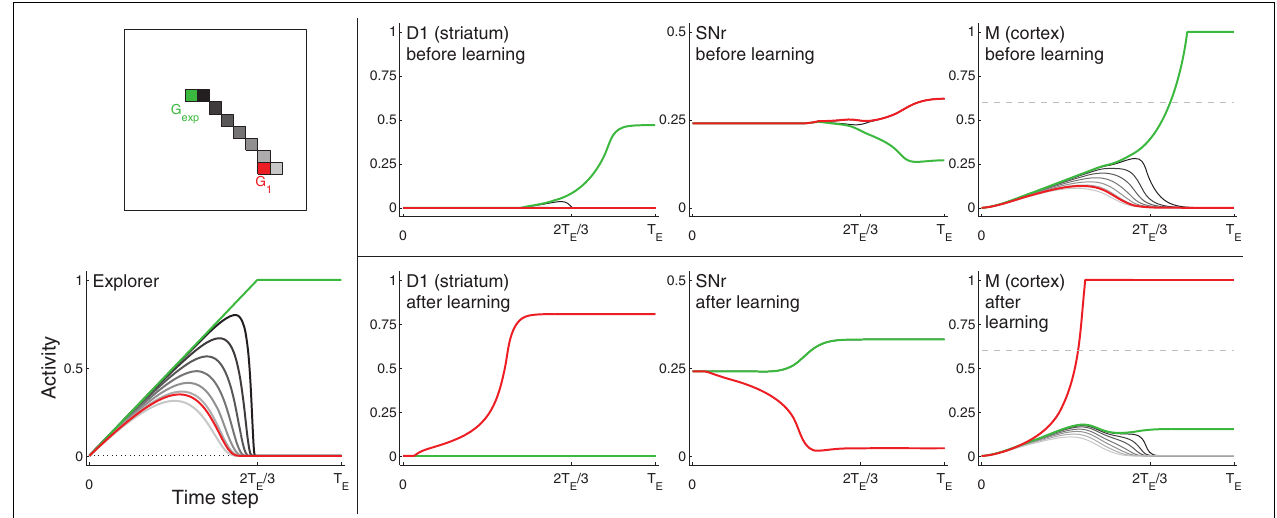
Bottom left: activities of Explorer neurons. Rightmost three graphs on top: activities of neurons from D1, SNr, and M before learning (i.e., before the target was hit). Rightmost three graphs on bottom: activities of the same neurons after learning, i.e., after the target was hit several times. Note that the maximum of the vertical axis of SNr is 0.5, while that of the other graphs is one. Horizontal dashed line of graphs for M (right) represents η